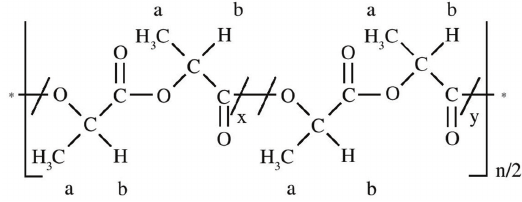
Figure 2. Molecular Structure of poly-L-co-D,L-lactic acid